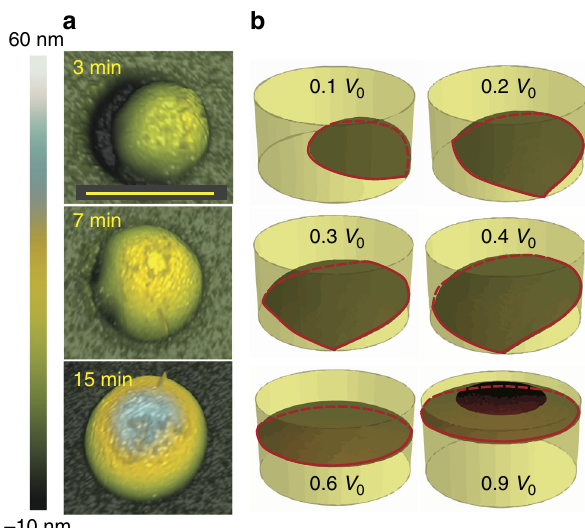
Fig. 2 Filling of the nanoscale holes in SiO 2 mask on silicon. a AFM images of the gallium droplets in a 45 nm diameter hole for three different pre- deposition times. Scale bar corresponds to 50 nm. b Illustrations of the evolution of the equilibrium droplet shape for increasing values of their volume. V 0 is the total volume of the hole. At small volumes, the droplet starts wetting asymmetrically from one side of the hole until the bottom interface is in full contact with the liquid phase. Further fi lling proceeds by increasing the wetting at the sidewalls. The morphologies were obtained using Surface Evolver for sessile droplets constrained in a cylindrical cavity with an aspect ratio of